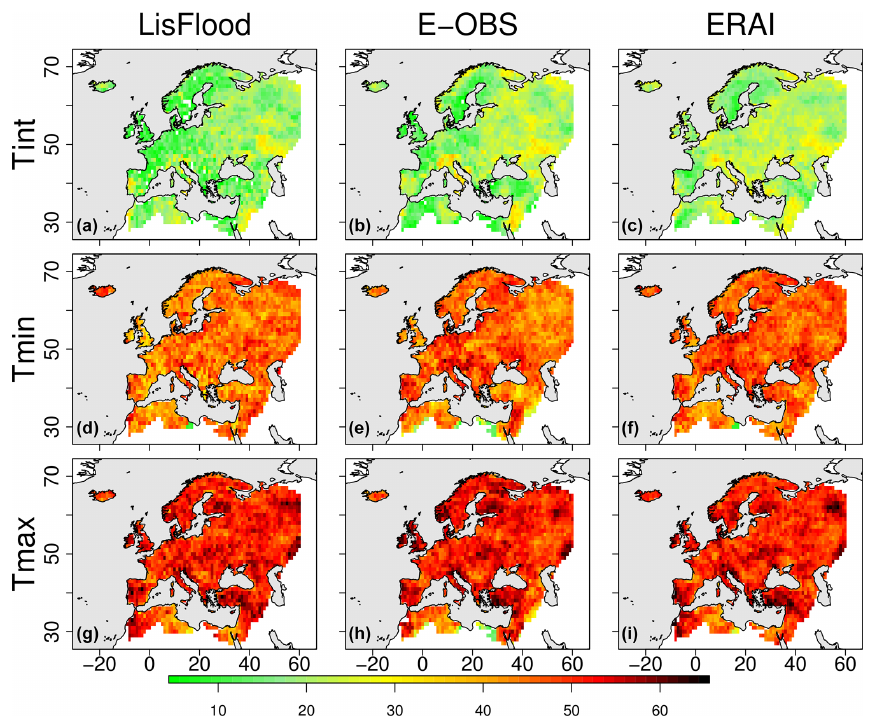
Figure 4. Number of occurrences of heat waves in Europe from 1995 to 2015 using the intersection of both T min and T max (Tint, a–c ), only T min (d–f) , and only T max (g–i) with LisFlood (a, d, g) , E-OBS (b, e, h) and ERAI (c, f, i)